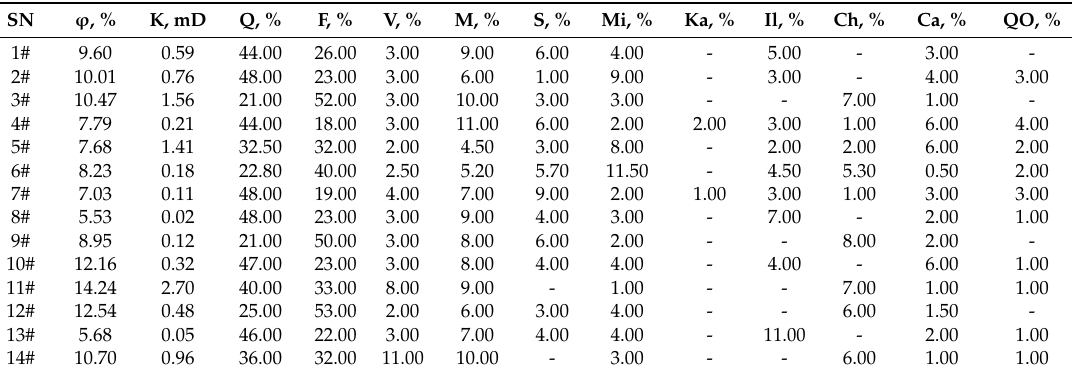
Figure 1. ( a ) Location map that shows the research area in the southwestern Ordos Basin, China (modified after Gao and Li, 2015 [13]; Cui et al., 2017 [48]) and ( b ) generalized stratigraphic column of the research area (modified after Lai et al., 2016 [49]). Table 1. Physical properties and petrological composition of Yanchang formation tight sandstones. 1